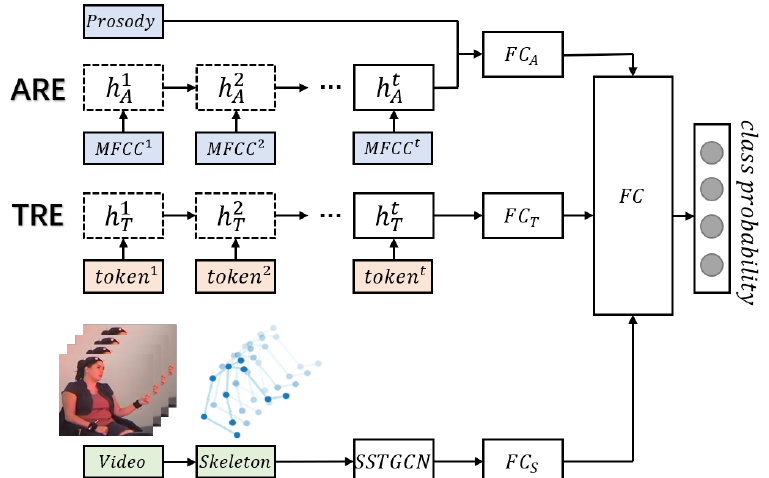
Figure 6. Skeleton enhanced emotion recognition network. Each FC represents a fully connected layer. The three fully connected layers on the left ( FC A , FC T , FC S ) are used for adjusting the dimensions of the representation vectors of audio, text, and skeleton. The fully connected layer on the right is used to learn the weights of these features and make final prediction.